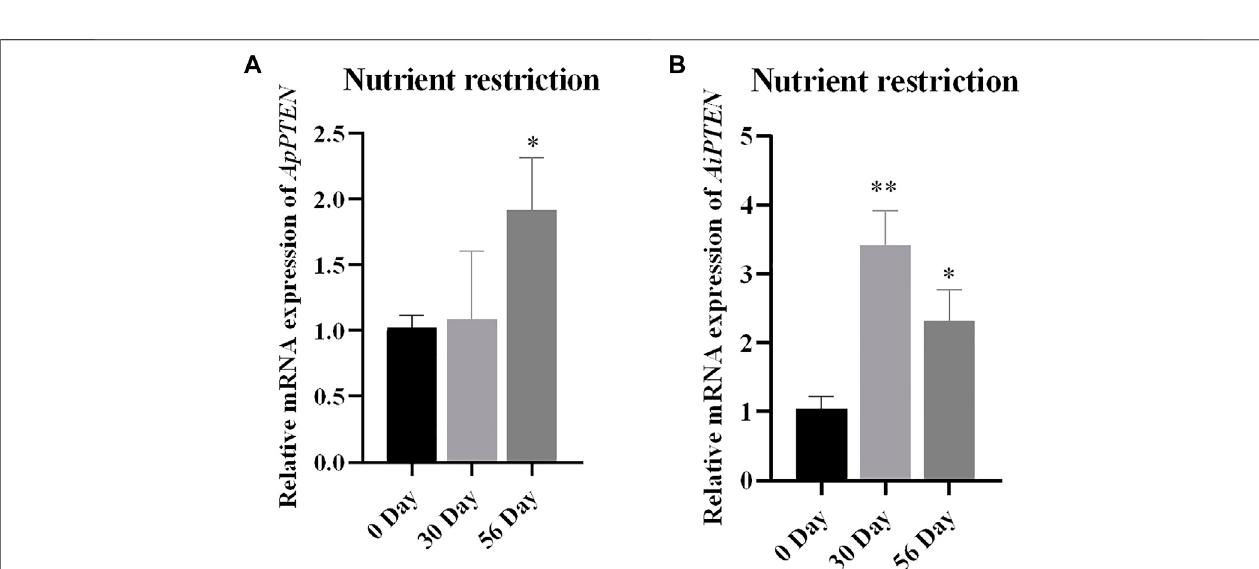
FIGURE 7 | Relative mRNA expressions of ApPTEN (A) and AiPTEN (B) in hepatopancreas under.